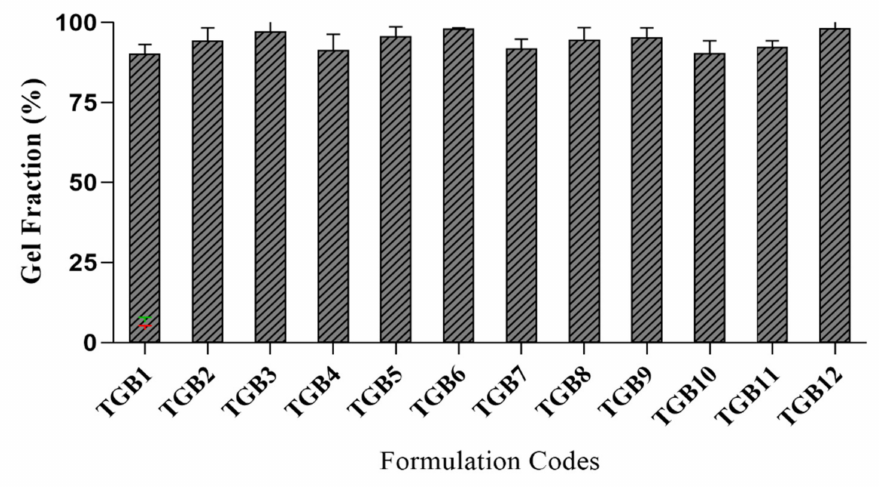
Figure 8. Gel fraction (%) results of hydrogel formulations (TGB1–TGB12). MBA formulations (TGB7–TGB9) with variable quantities (0.05 to 0.1 g) resulted in an increased gel fraction, i.e., from 91.82 to 98.12, as a result of the increased MBA concentrations caused by increased interactions between polymeric and monomeric units in the form of cross linking. By increasing MBA content, cross linking was promoted, owing to the reduced pore size of the developed networks. As a result, hydrogels with a compact and hard structure were obtained. The increased MBA content also resulted in an enhanced cross-linking density of the